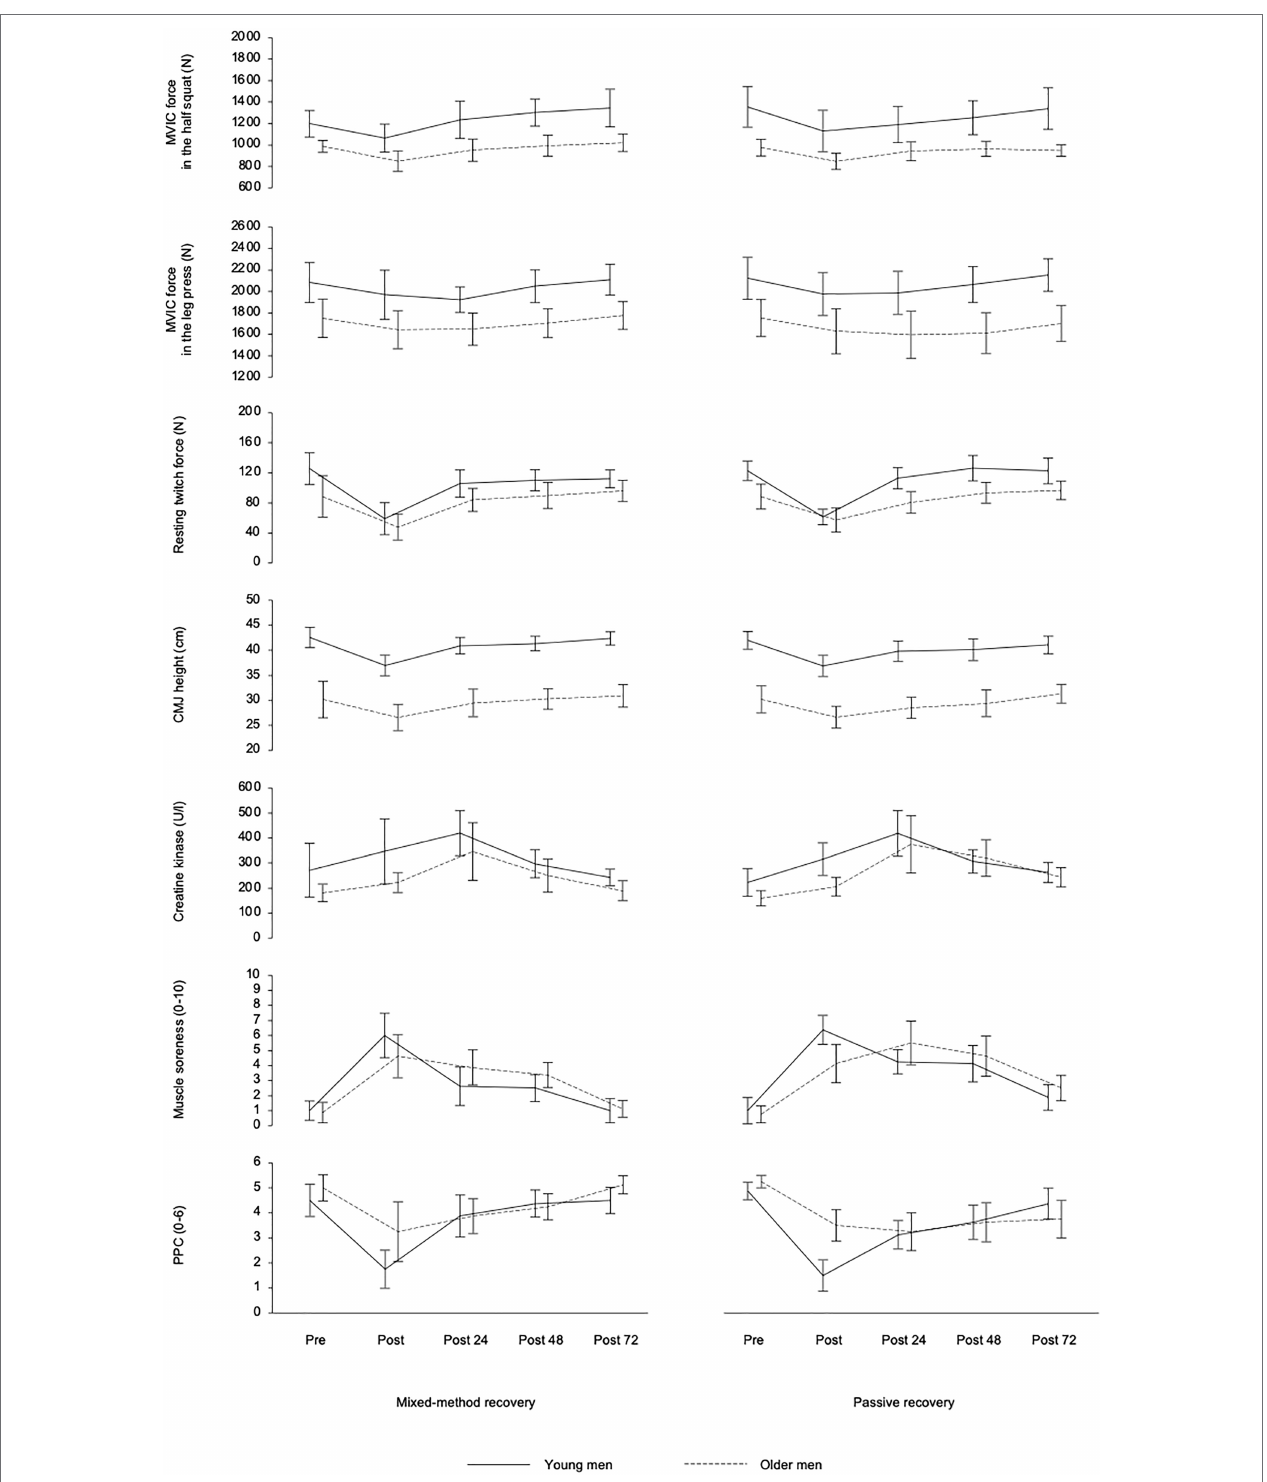
FIGURE 2 | Mean (± 95% confidence intervals) of the young and older athletes in the two recovery conditions for maximal voluntary isometric contraction (MVIC) force in the half squat and leg press, resting twitch force of the knee extensors, countermovement jump (CMJ) height, serum concentration of creatine kinase, muscle soreness, and perceived physical performance capability (PPC) before (Pre) and after (Post) squat exercise sessions as well as after 24 h (post-24), 48 h (post-48), and 72 h (post-72) of